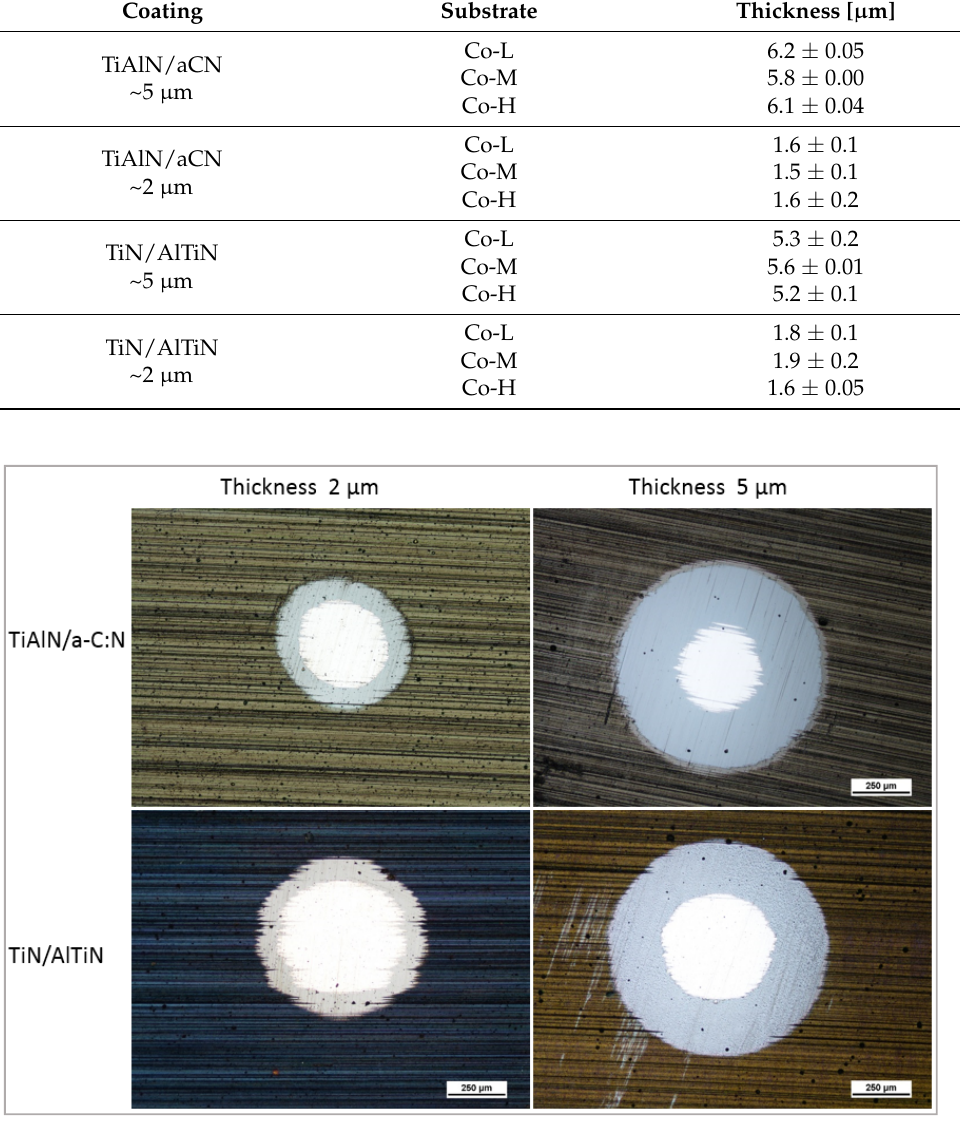
Table 5. Critical load L C3 of the nanolayer TiN/AlTiN and TiAlN/a-C:N double layer coatings de-